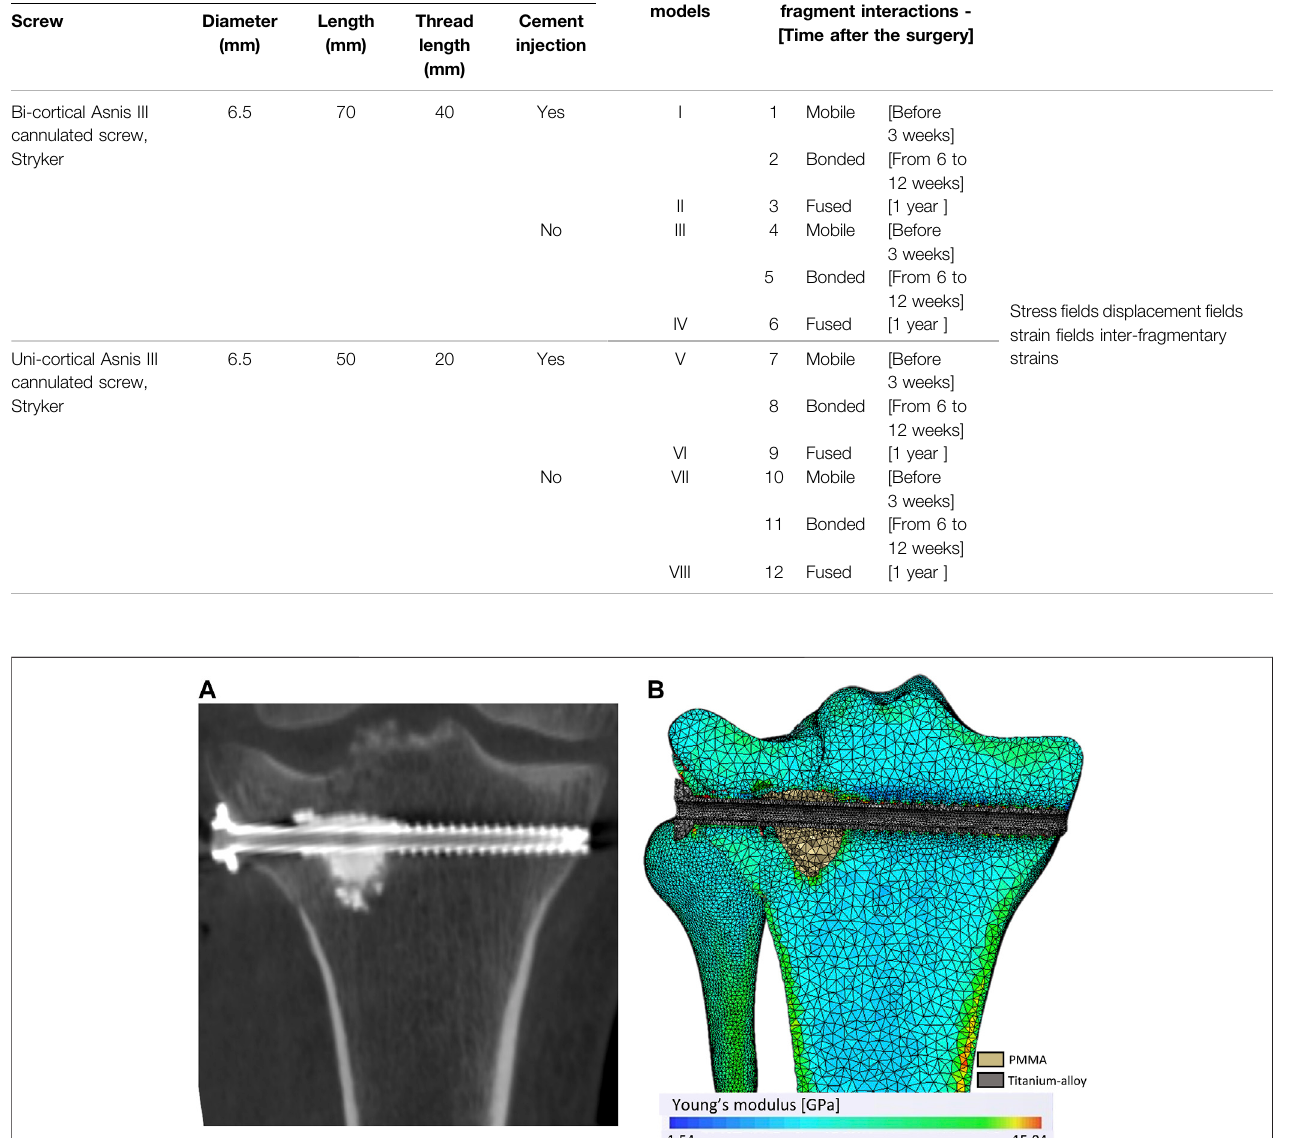
Frontiers in Bioengineering and Biotechnology |